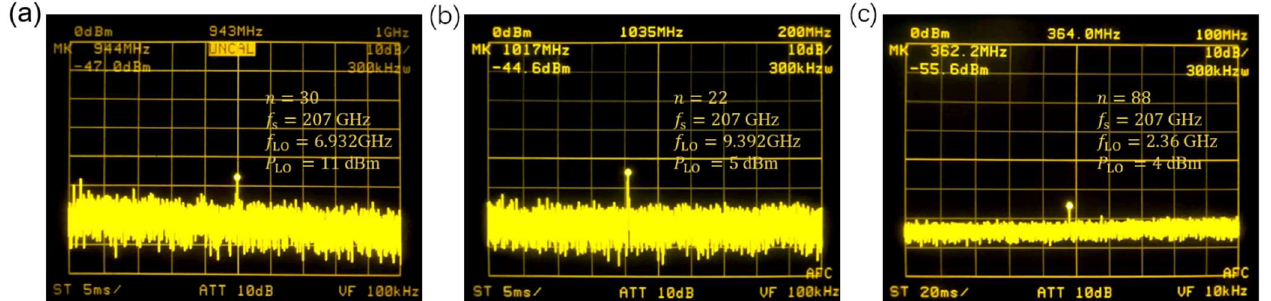
Figure 6. Measured frequency spectra of the IF output from the JJ ( a ) Mixer 1 coupled with Antenna 1: bowtie loaded by lumped-element stubs when f LO = 6.932 GHz, P LO = 11 dBm, n = 30, and ( b ) when f LO = 9.392 GHz, P LO = 5 dBm, n = 22; ( c ) Mixer 2 coupled with Antenna 2: bowtie loaded by open-end stubs when f LO = 2.36 GHz, P LO = 4 dBm, and n = 88 under a 0.207 THz radiation.